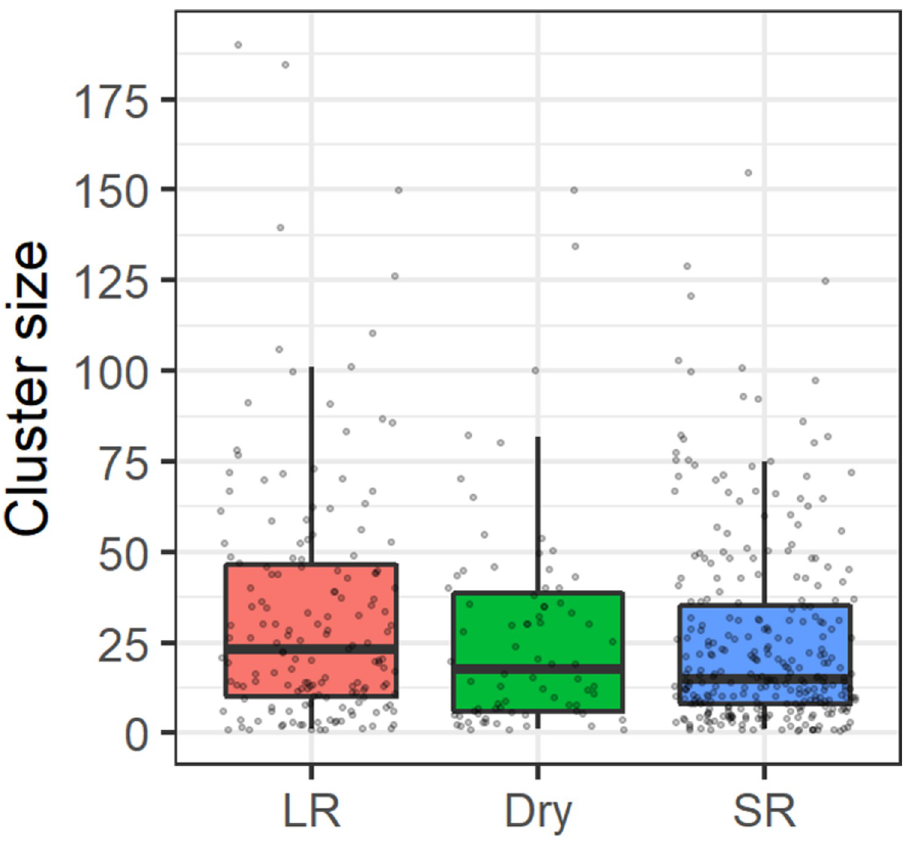
Fig 4. Box-plots (bold midline indicates the median, the upper and lower limits of the box represent the third and first quartiles) of observed baboon cluster sizes during seasonal (LR: Long rains; Dry: Dry season; SR: Short rains) line distance surveys in Lake Manyara National Park (Tanzania). The jittered grey points indicate observed cluster